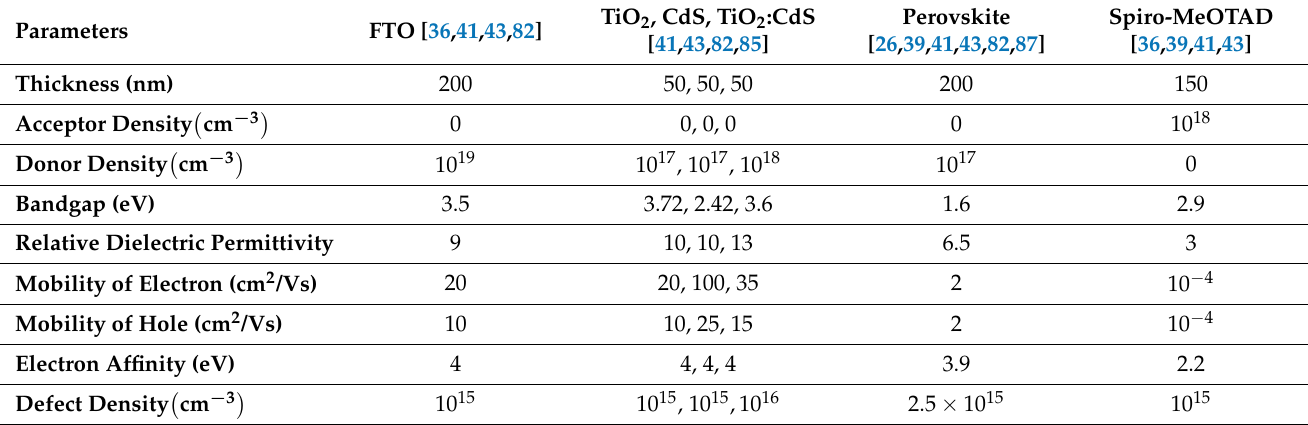
Table 1. Material parameters set in simulation.